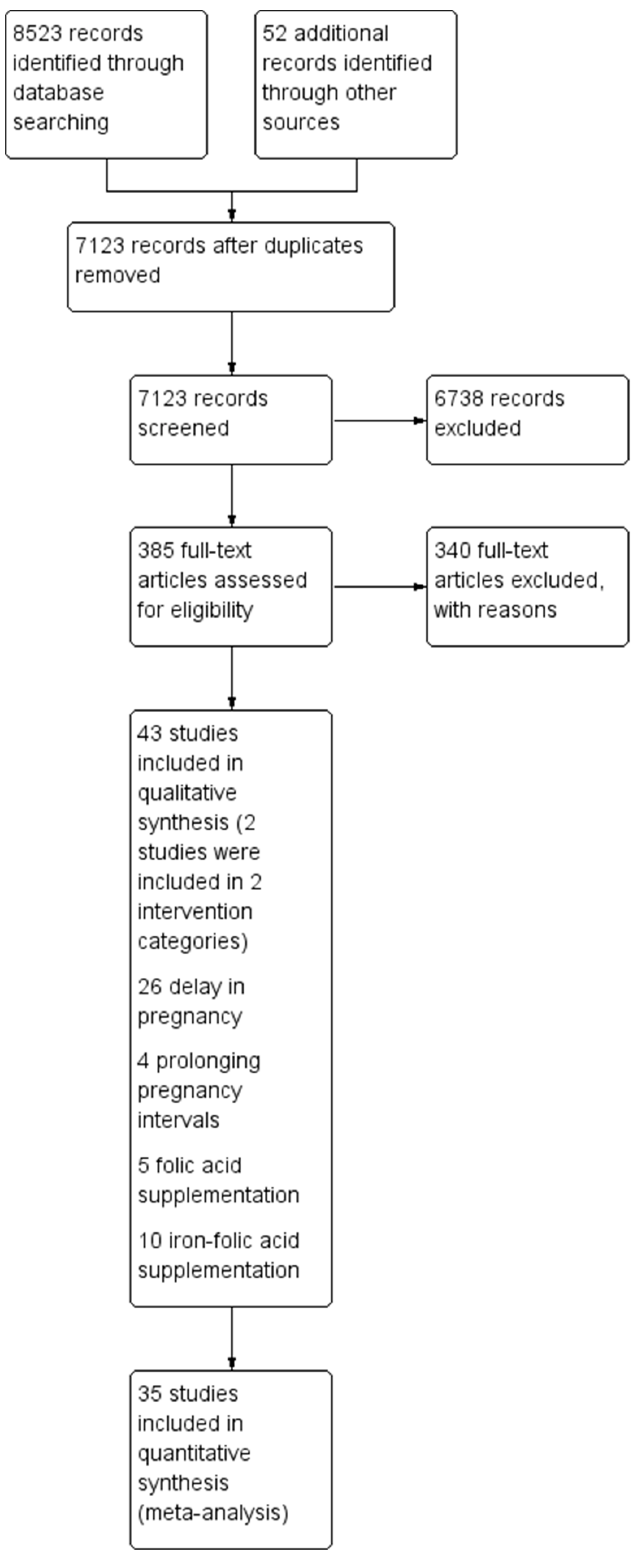
Figure 2. Preferred Reporting Items for Systematic Reviews and Meta-Analyses [PRISMA) flow Figure2. diagram.